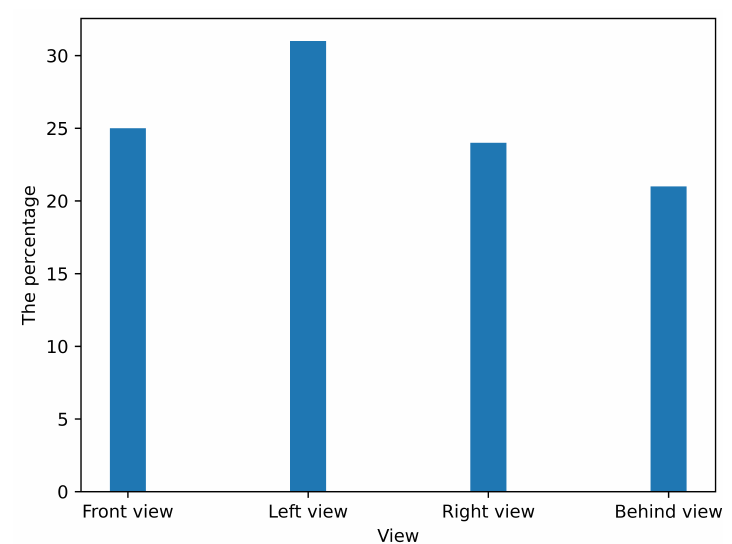
Figure 6. The distribution of vehicle